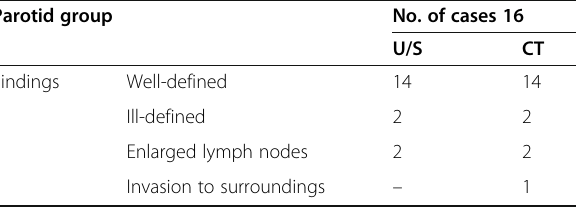
Table 4 Radiological findings in cases diagnosed as neoplasm Parotid group No. of cases 16 U/S